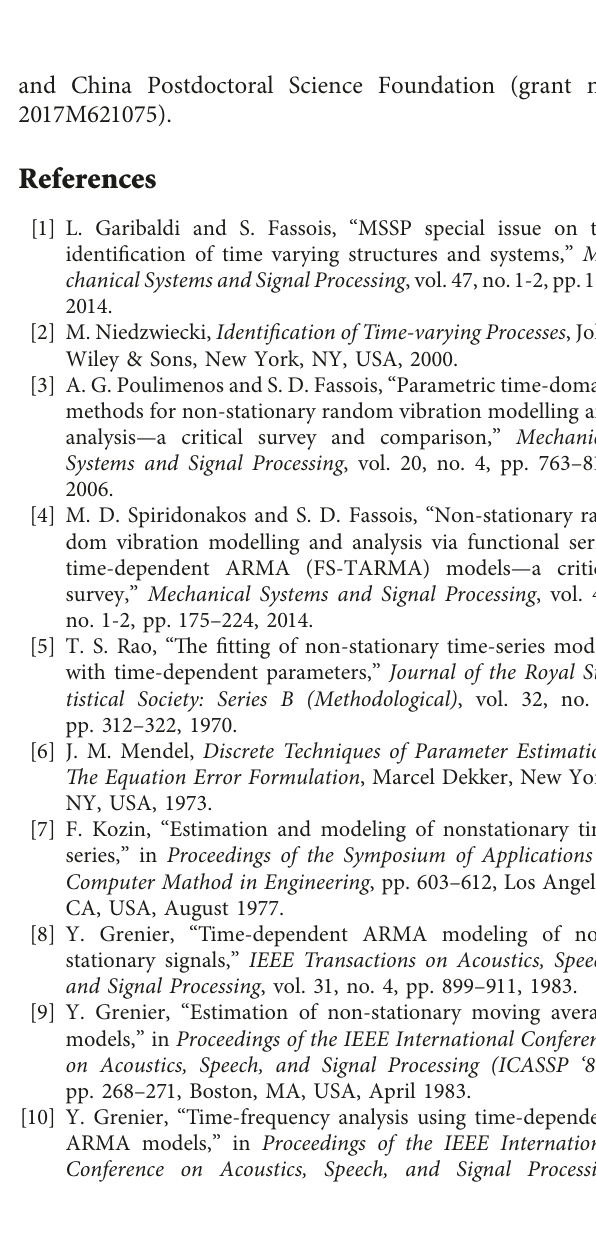
Figure 8: Natural frequency and power spectral density estimates by LS (a, c) and RR (b, d) for the laboratory TV structure when N (gray dots: natural frequency estimates from the 30 Monte Carlo tests; red dots: natural frequency estimates from the single test; green dashed lines: baseline values of natural